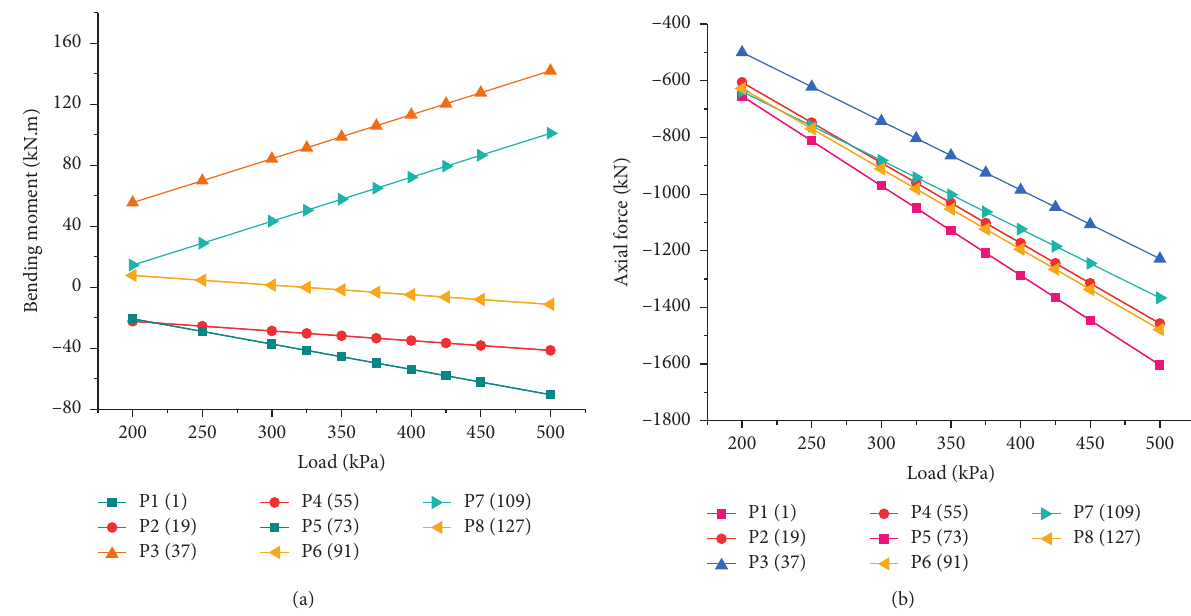
Figure 10: Internal force diagram of load mode I. (a) Load-moment diagram. (b) Load-axial